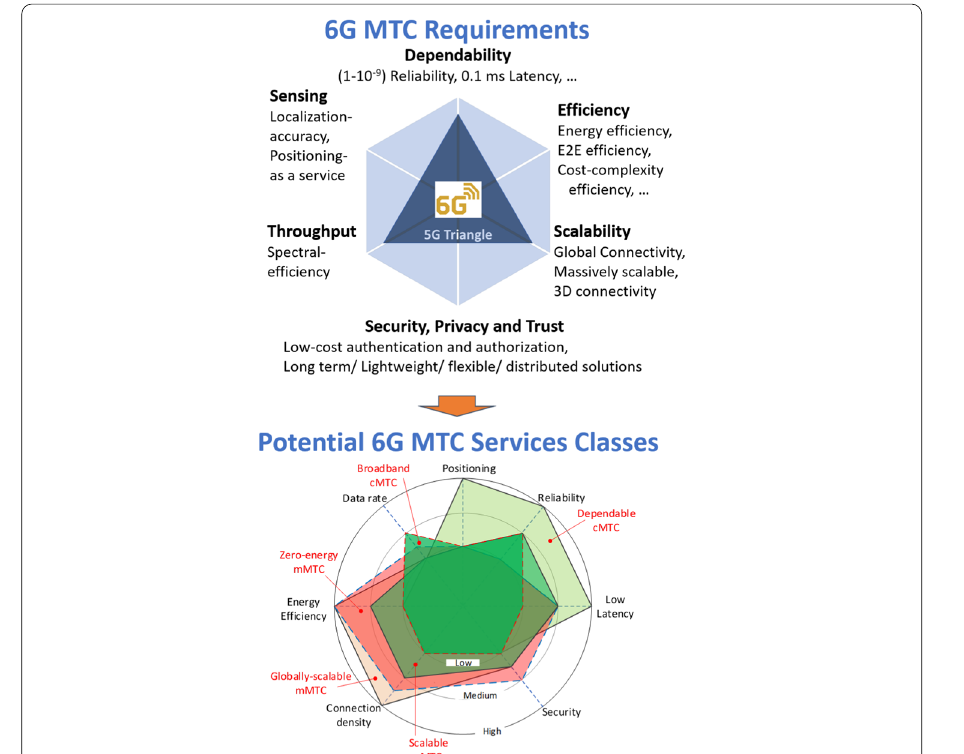
Fig. 1 MTC requirements and service classes towards 6G. Evolution of MTC requirements from the 5G triangle to the 6G hexagon (top), potential MTC specific service classes in 6G (bottom). The qualitative performance indicators of the potential new MTC services classes in 6G are collected from the different numbers predicted in various initial 6G vision papers (e.g., [13, 14, 18,